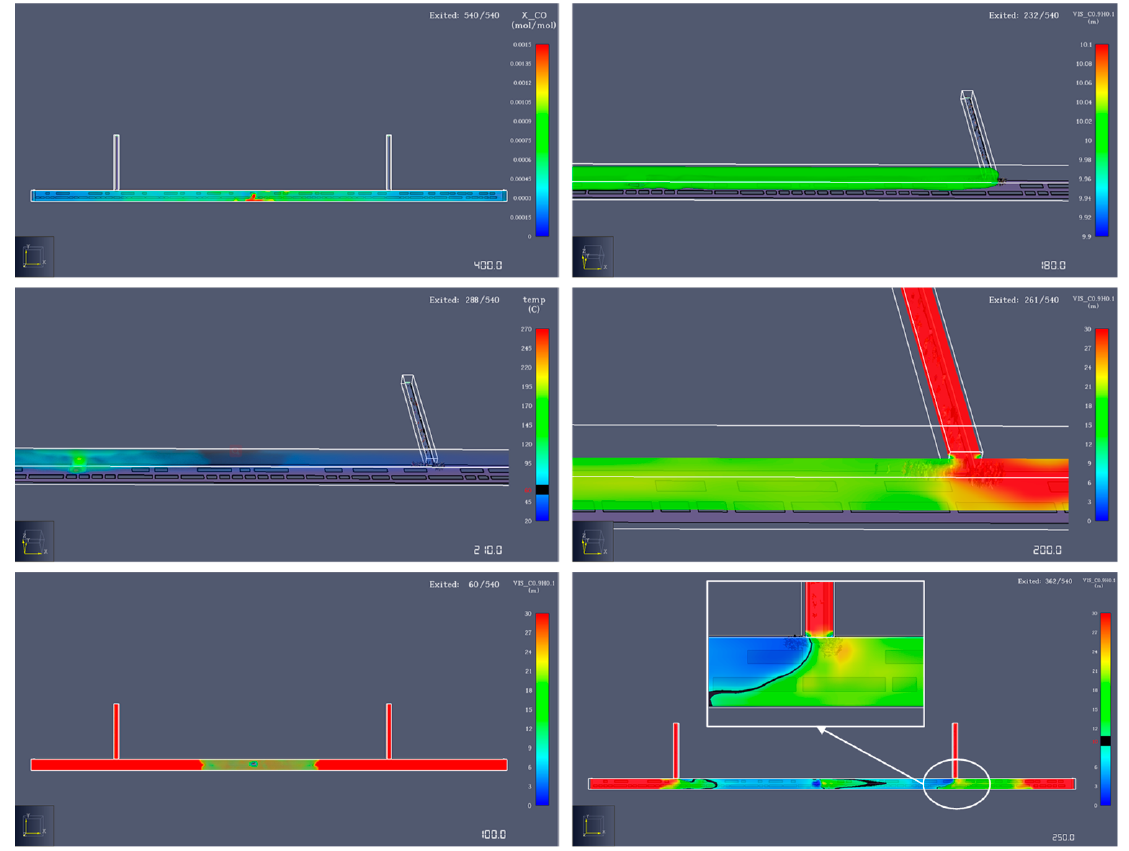
Figure 21. Results of evacuation simulation of heavy congestion.